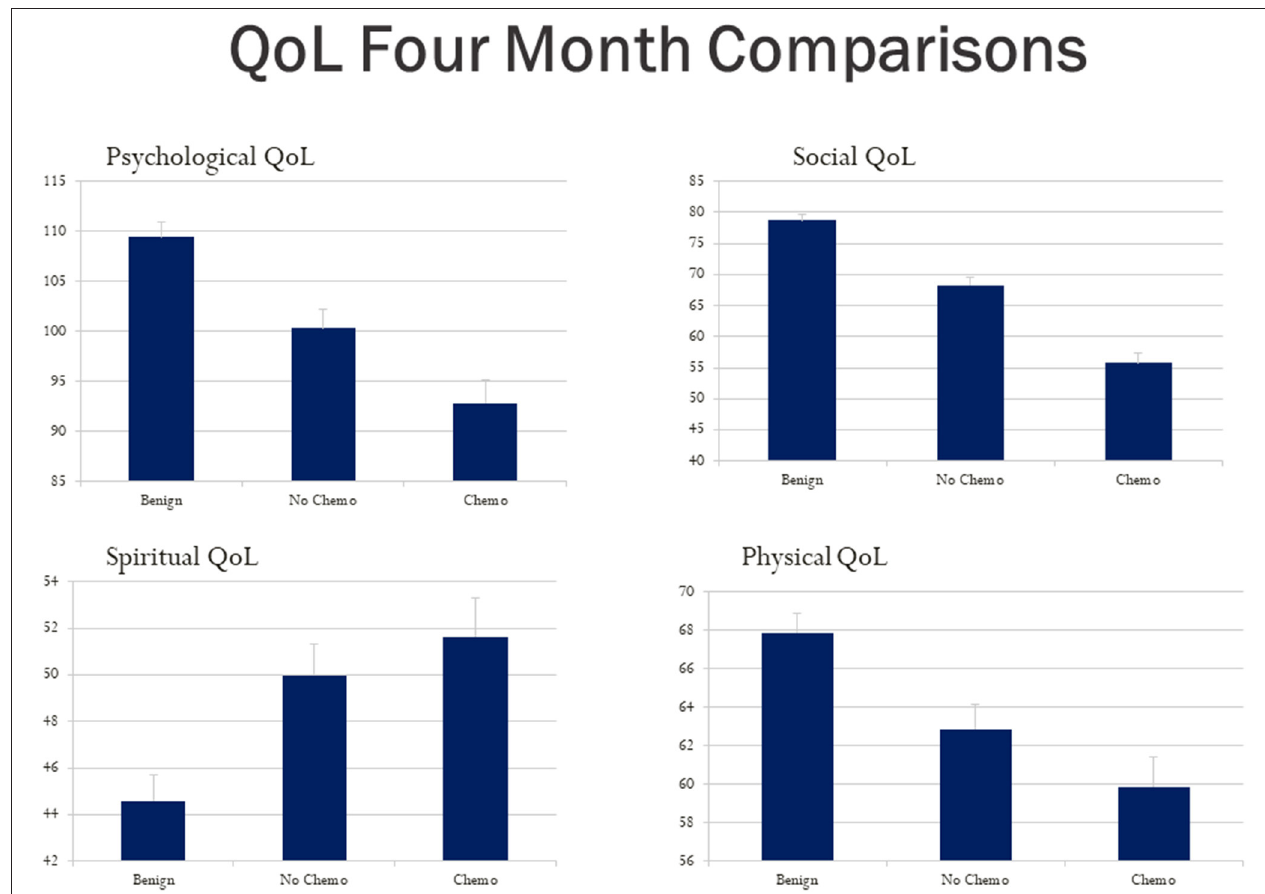
FIGURE 3 | Hope Quality of Life (QoL) questionnaire total score bar graphs for the benign (breast lump autopsy), no-chemo (treatment for breast cancer), and chemo (treatment for breast cancer) groups. Higher scores mean better QoL for the psychological, social, spiritual, and physical domains respectively. The SE value for each group is capped above its